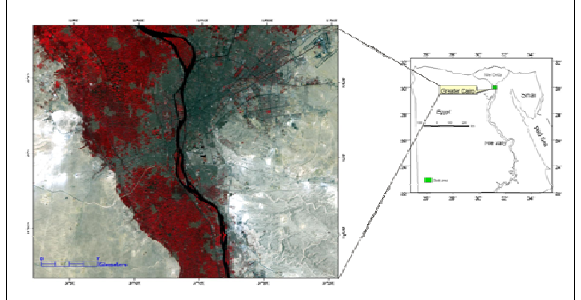
Figure 1. Location of the study area